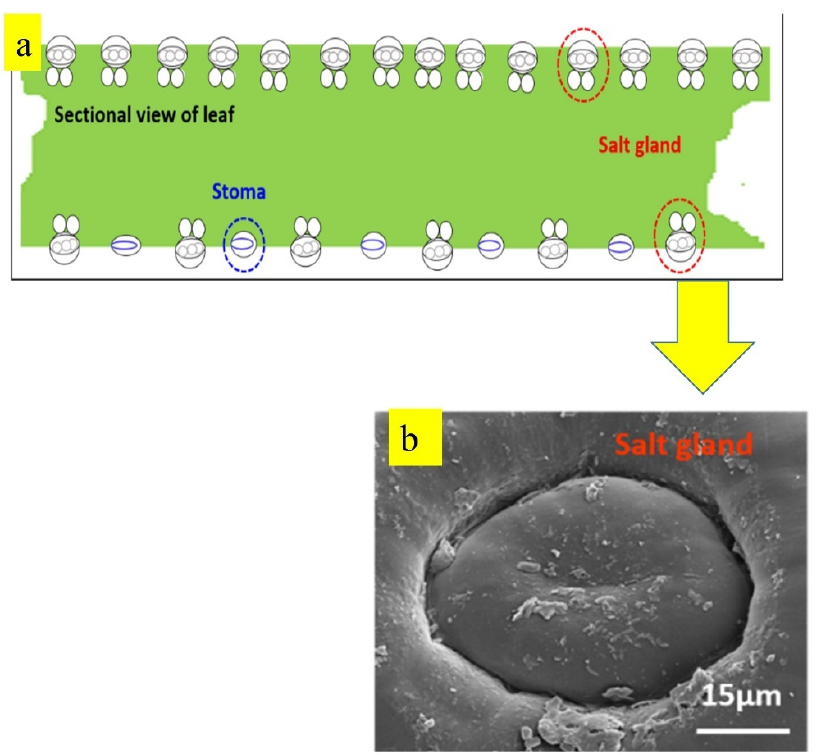
Figure 18. ( a ) Schematic showing the distribution of salt glands and stomata on a mangrove leaf that regulate salt transportation in and out of leaf. ( b ) SEM image of a salt gland of a mangrove leaf [221].